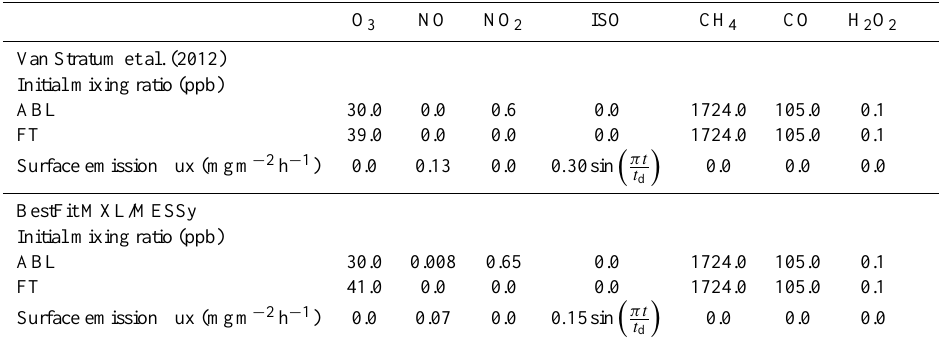
Table A2. Initial mixing ratio in ABL and FT, and surface emission fluxes of the reactants for the different runs in MXL/MESSy and MXLCH. Species in the reaction mechanism that are not included in this table have an initial concentration of zero and no surface emissions. For O 2 and N 2 we have imposed the values 2 × 10 8 and 8 × 10 8 ppb,